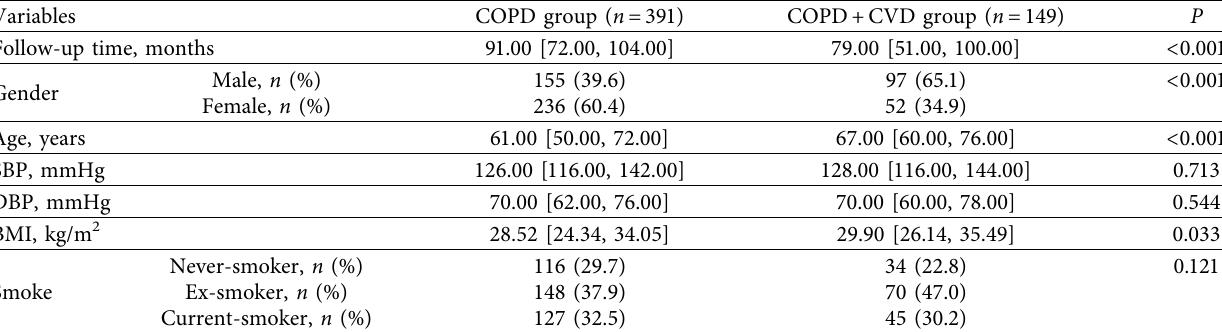
Figure 1: Flow chart of the study protocol. The COPD+CVD group included participants with COPD coexisting with CVD. The COPD group included participants with COPD but without Table 1: Baseline demographic characteristics of the included participants.